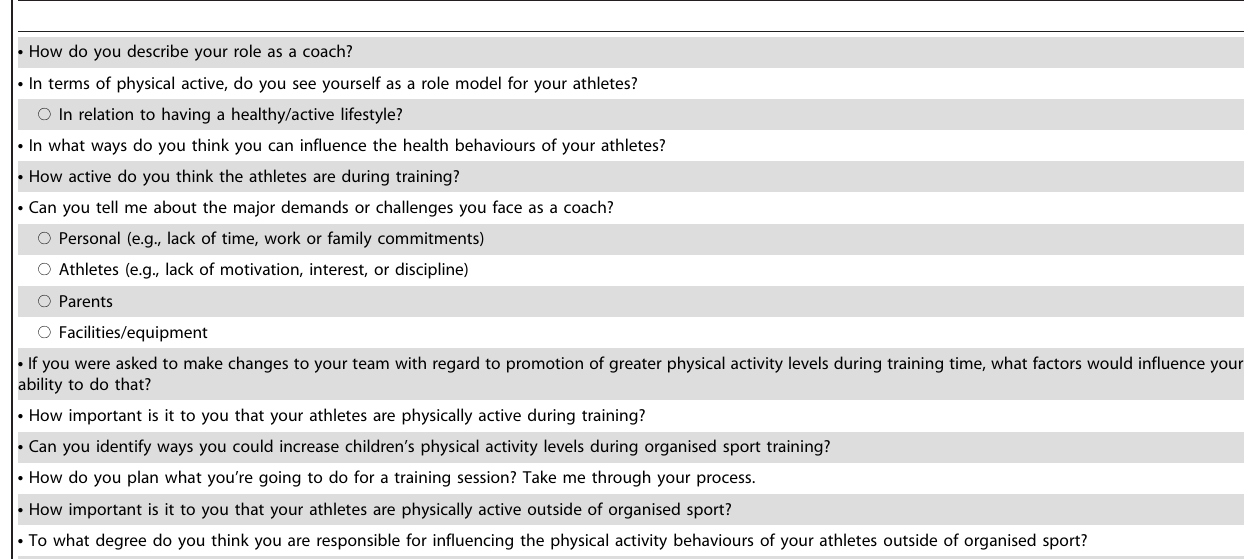
Table 1. Interview questions, prompts, and